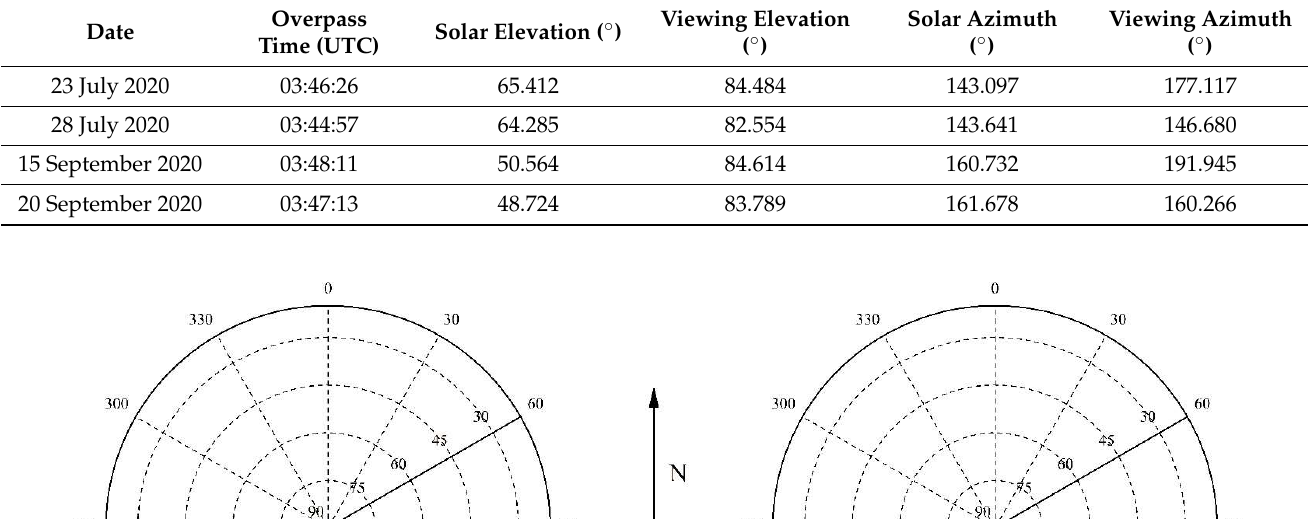
Table 4. Solar–target–satellite acquisition geometric conditions of the GF7 satellite at the Baotou site.